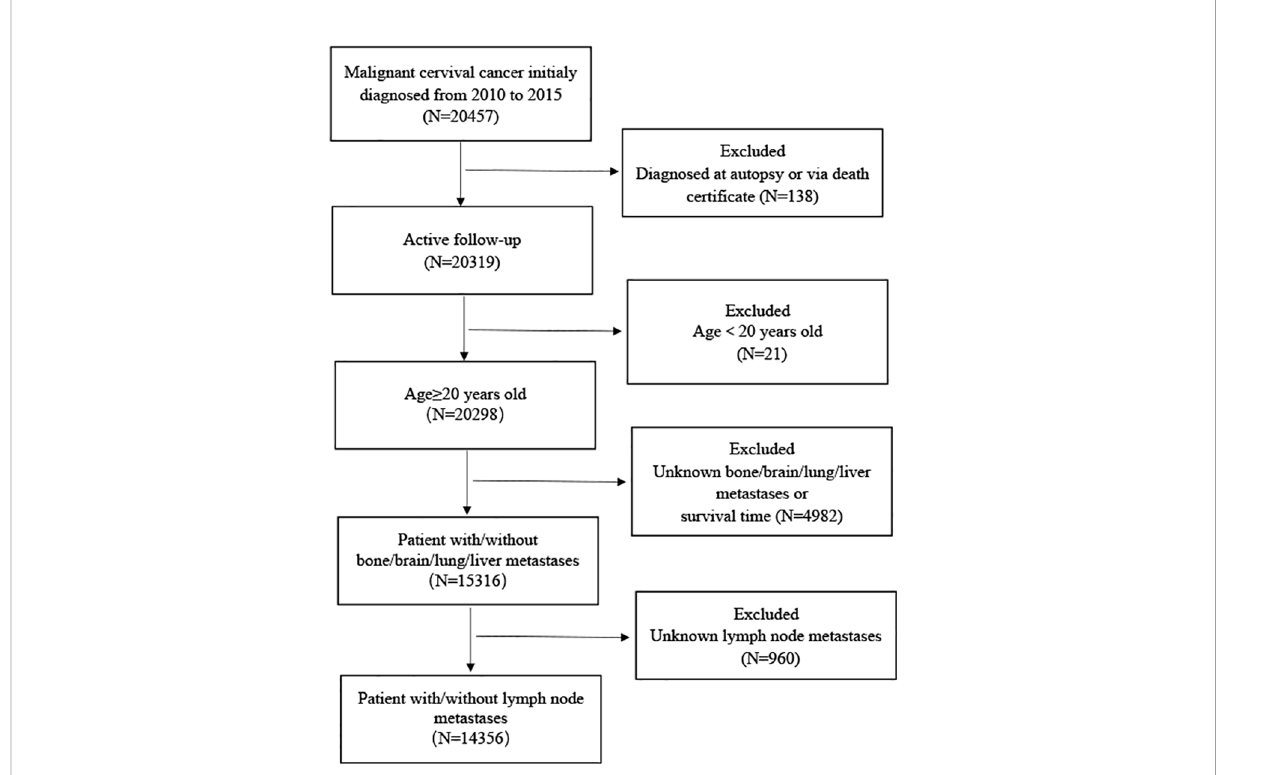
FIGURE 1 Flow chart showing the study design and patient